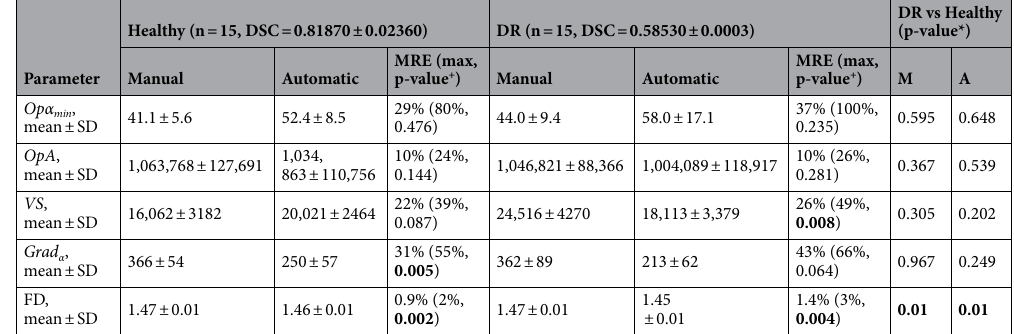
Table 3. The comparison of alpha-shape descriptors and FD obtained from manual annotation and automatic segmentation. DSC dice similarity coefficient with manual annotation as reference, MRE mean of the relative error with manual annotation as reference, Max maximum relative error with manual annotation as reference. n, number of images. + Pearson correlation test with null hypothesis that the correlation coefficient is zero. * Wilcoxon rank sum with null hypothesis that medians are equal between